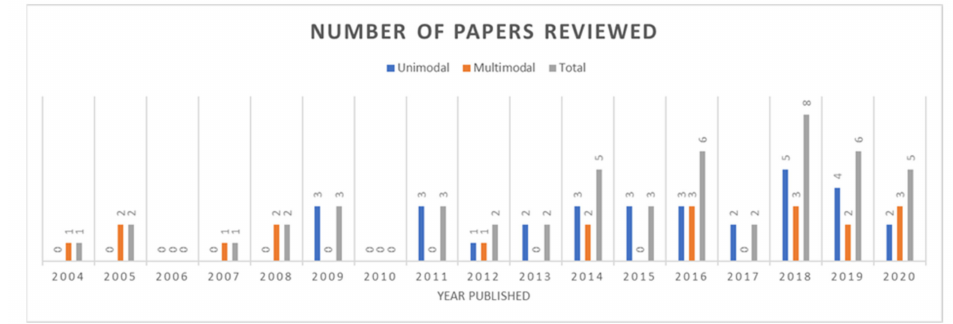
Figure 1. Overview of the years selected studies were